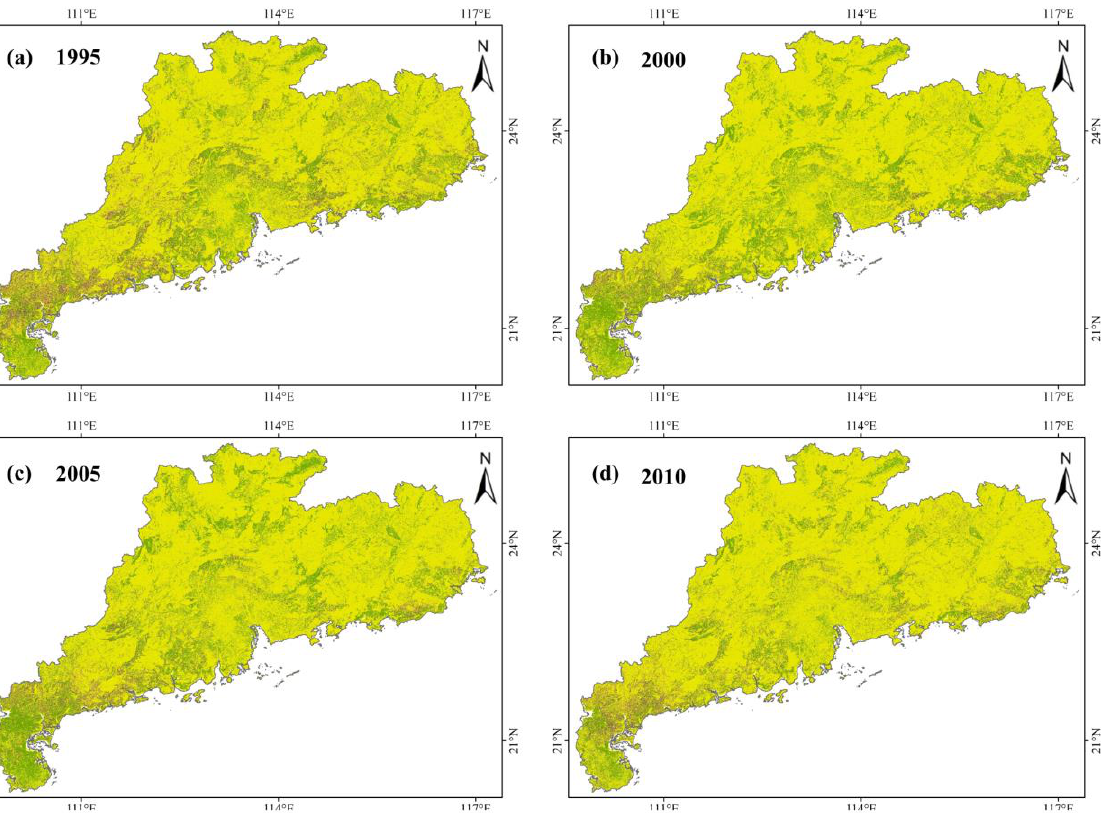
Figure 12. Annual cropland abandonment maps of Guangdong in 1995(a), 2000(b), 2005(c), 2010(d), 2015(e), and 2020(f). From the detail view of typical area of cropland abandonment, Figures 13a1 and 13a2 show the spatial-temporal changes in plain areas over a 6-year period. Abandonment mainly occurred in fragmented cropland, and the area thereof was small compared to the large area of contiguous cropland. Figures 13b1,b2 show that cropland decreased sharply in the PRD from 2005 to 2010 due to land-use transformation from cropland to fishponds and built-up land. As shown in Figure 13c1,c2, a large area of cropland in the mountainous regions had been abandoned by 2020 due to the fragmentation of cultivated land, and complex terrain in hilly and mountainous areas make it difficult to meet mechanized ag- ricultural management, while the management is high-cost and labor-intensive work,